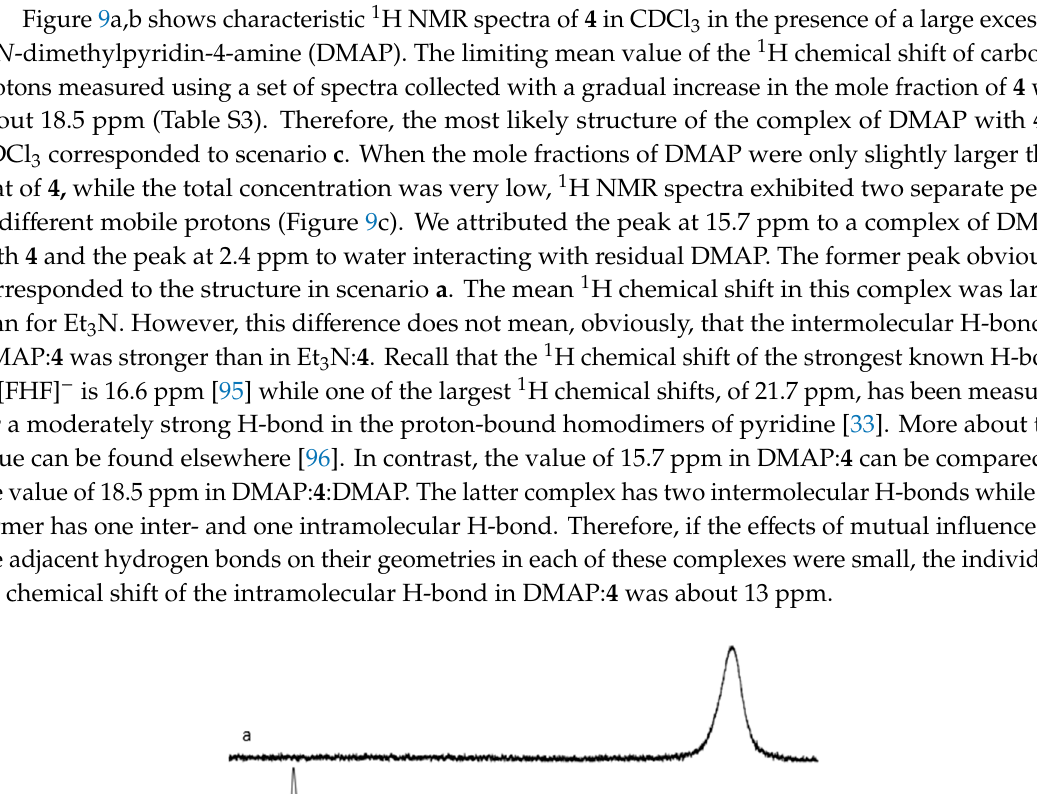
Figure 8. Characteristic 1 H NMR spectra of 3 and 4 in CDCl 3 at 300 K in the presence of Et 3 N. The signals of OH-protons are marked by asterisks. The mole fractions are ( a ) water: 4 :Et 3 N = 1:1.2:35, ( b ) water: 4 :Et 3 N = 1:8.7:35, and ( c ) water: 3 :Et 3 N = 1:8.7:35.